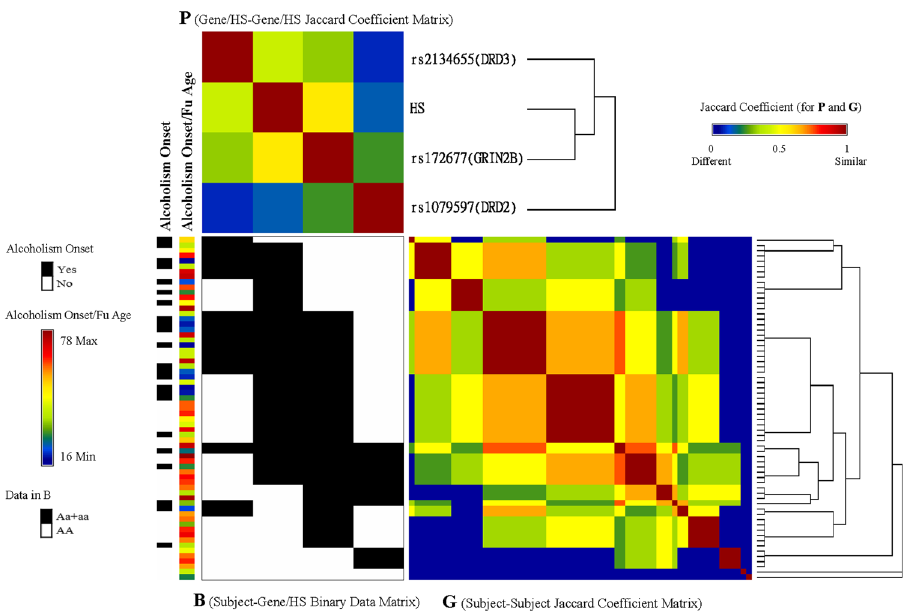
Figure 4. GAP clustering of three multiple SNPs (genes) and habitual smoking of 65